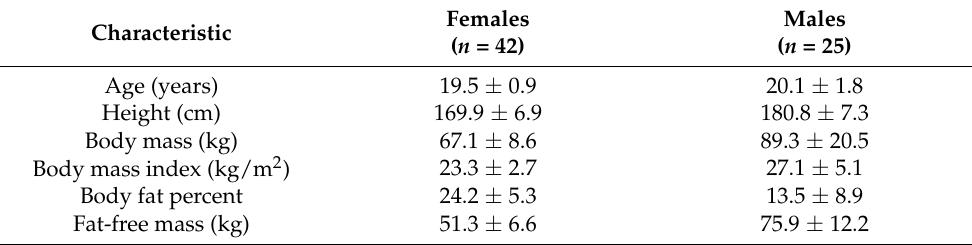
Table 1. Descriptive summary of physical characteristics by